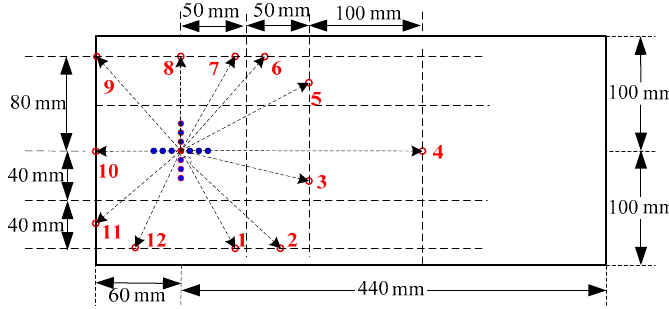
Figure 6. Schematic diagram of the piezoelectric sensor and energizing sensing channel.